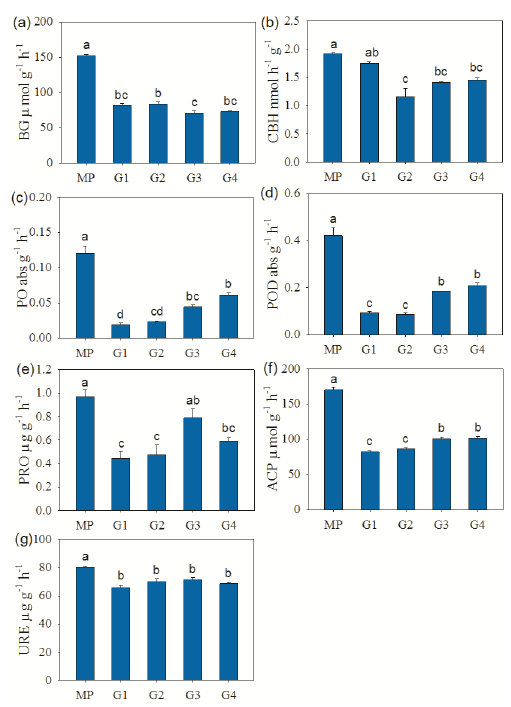
Figure 4. Soil enzyme activities in the Pinus and the successive Eucalyptus plantations. MP, G1, G2, G3 and G4 refer to the Pinus plantation and the first, second, third and fourth generation Eucalyp- tus plantations, respectively. BG, β -glucosidase; CBH, cellobiosi- dase; PO, phenoloxidase; POD, peroxidase; PRO, protease; URE, urease and ACP, acid phosphatase. Enzyme activities with the same letter are not significantly different at p <0.05.